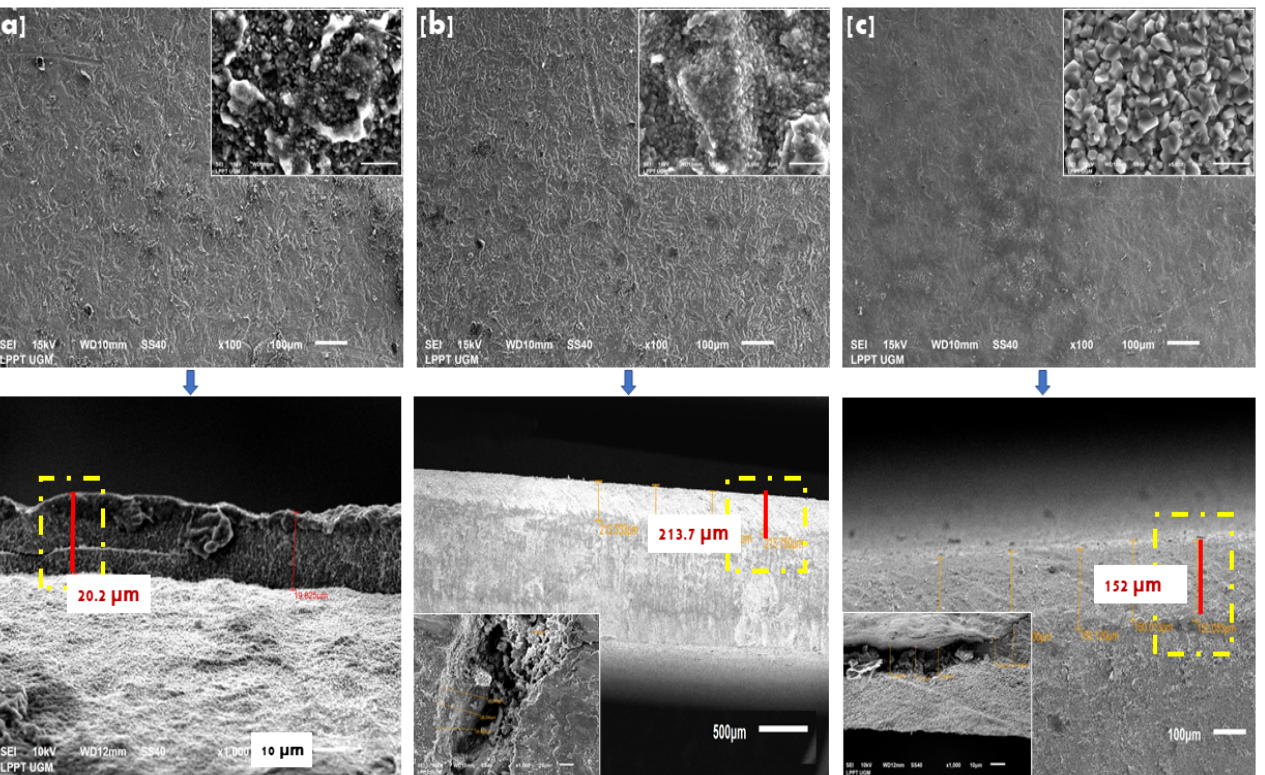
Figure 6. Surface morphology and cross-section (yellow dash-dot line) on substrate Ti/HAp-1 ( a ), Ti/HAP-3 ( b ), and Ti/HAp-coll ( c ).